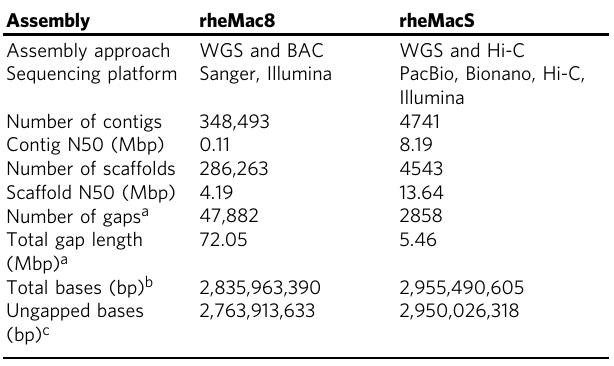
Table 1 Comparison of assembly statistics between rheMac8 and